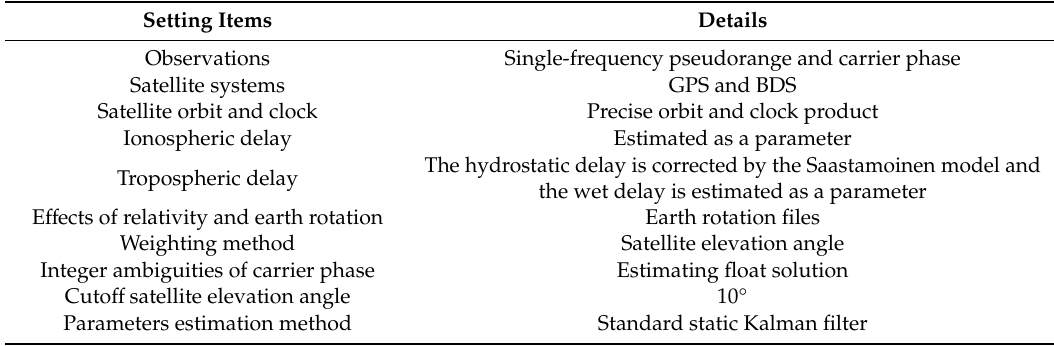
Figure 10. The multipath errors of L1 (blue), L5 or L2 (orange) code measurements of G26 satellite with the Mate30 ( a ), the V20 ( b ) and the Trimble R8 ( c ) in the first experiment. The standard deviations of the code multipath errors are shown with the corresponding colors in meters.